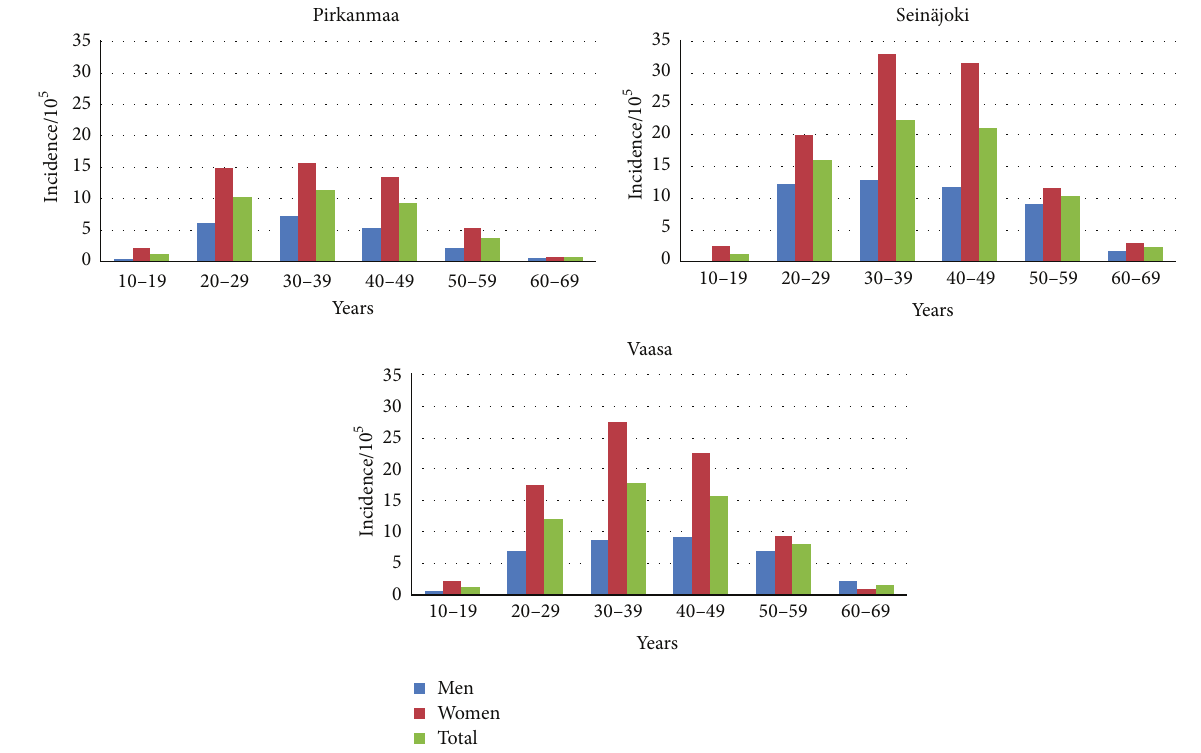
Figure 4: Incidence of MS in the 10-year-age groups in Pirkanmaa, Sein¨ajoki, and Vaasa hospital districts during the period 1981–2010.